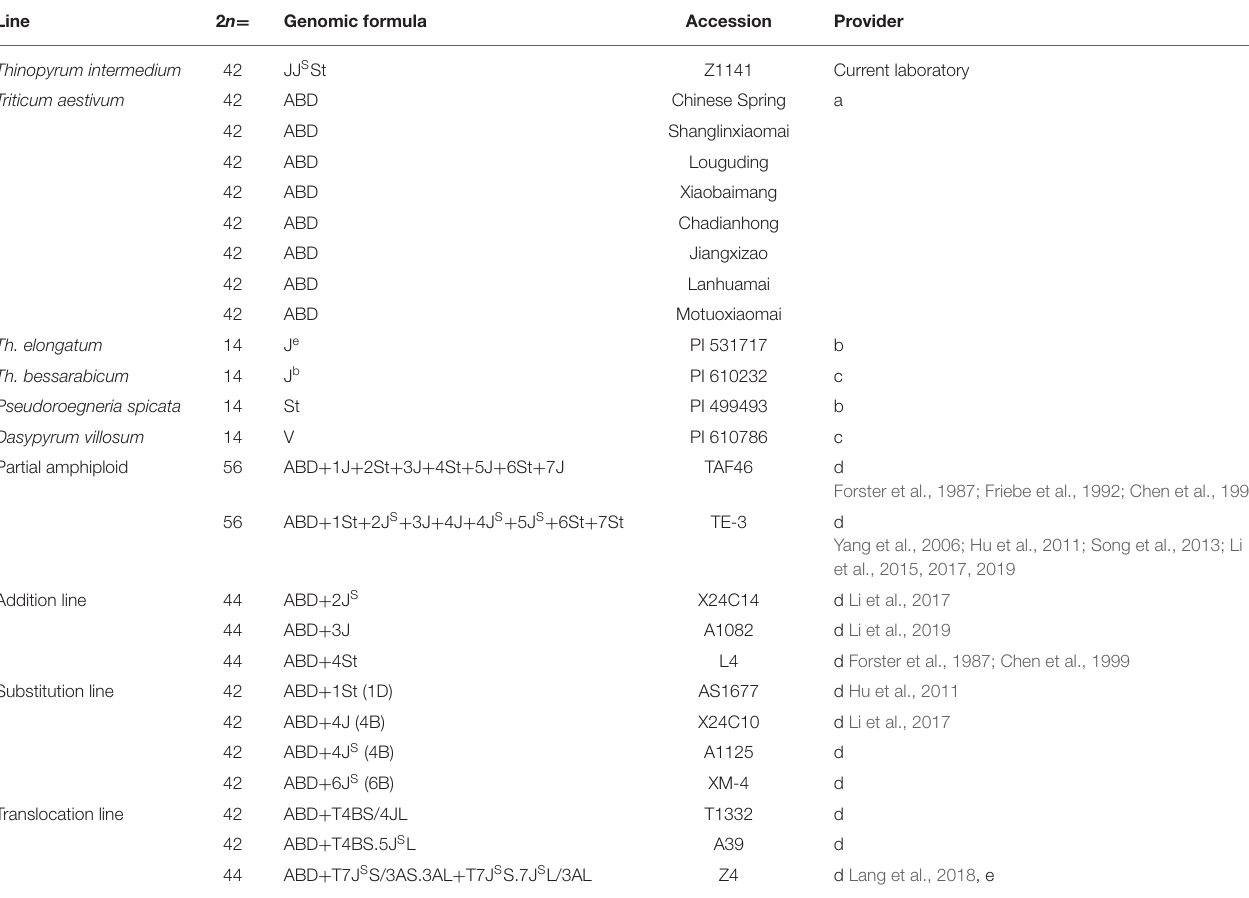
TABLE 1 | Plant materials used in this